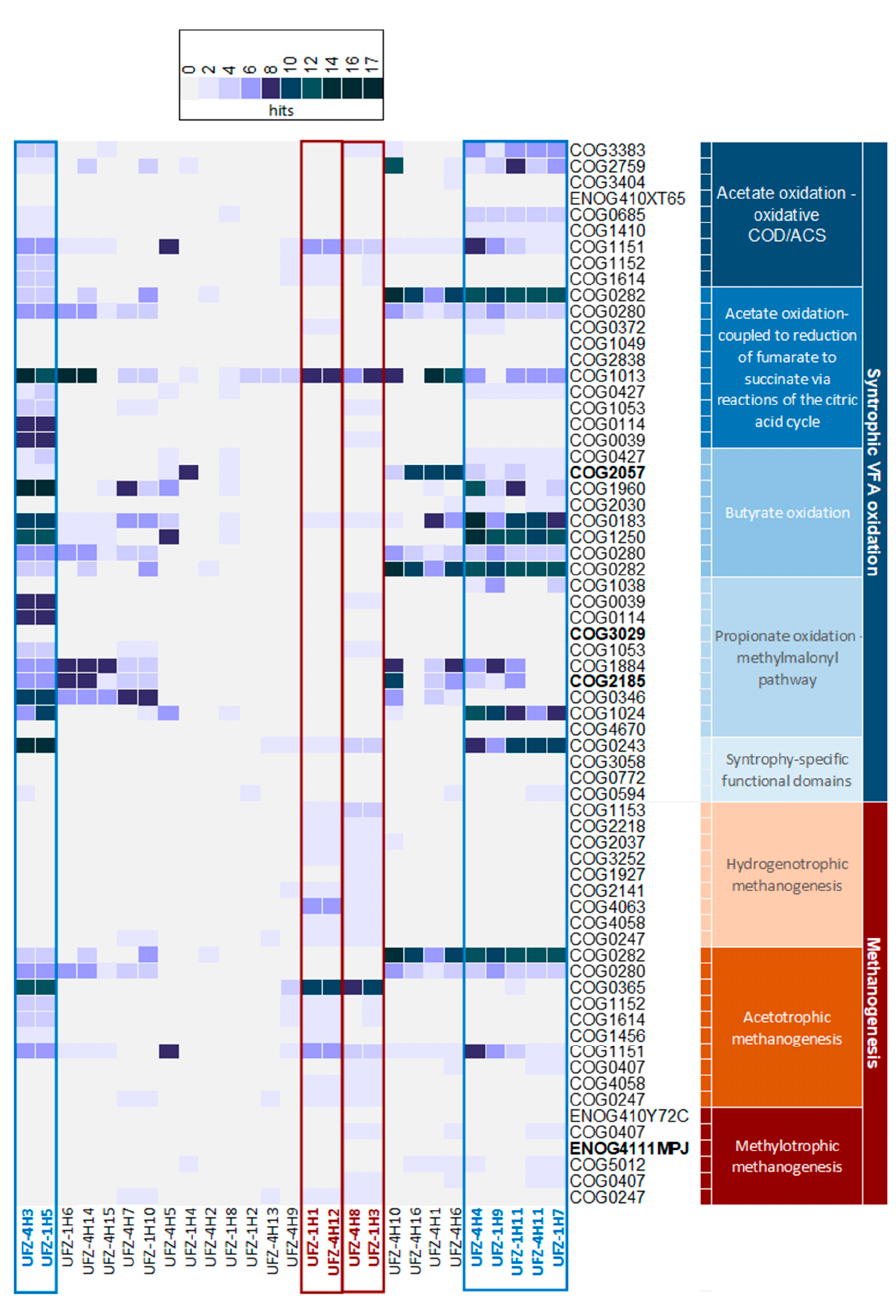
Figure 3. Pathway analysis of hybrid assembly MAGs. “Hits” refers to the number of genes per MAG and pathway. Rows contain selected genes of pathways of interest. For detailed information, the COG/EggNOG-IDs are listed in Supplementary File S1. IDs in bold indicate alternatives to searched gene IDs, or were not available (see Supplementary File S1). MAGs indicated in blue show similar patterns in syntrophic SCFA oxidation. MAGs indicated in red show similar patterns in